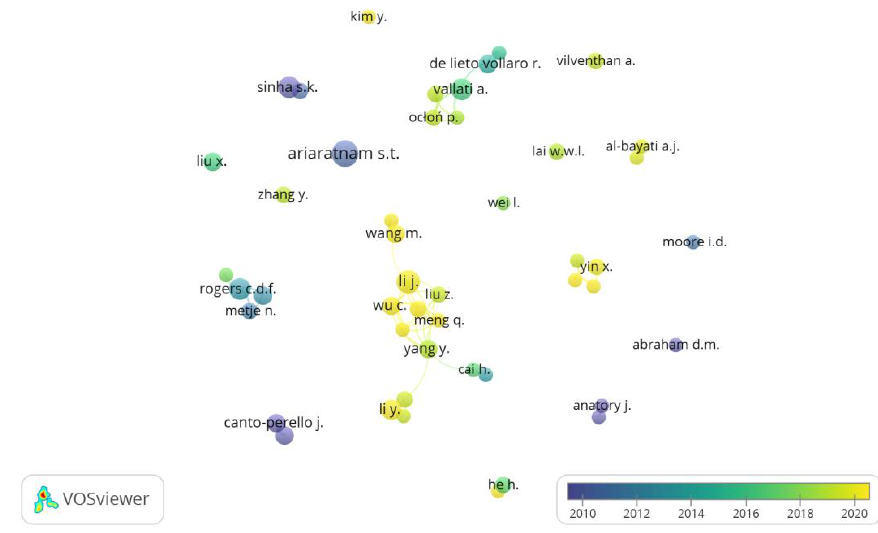
Figure 7. Co-authorship network regarding scholars.